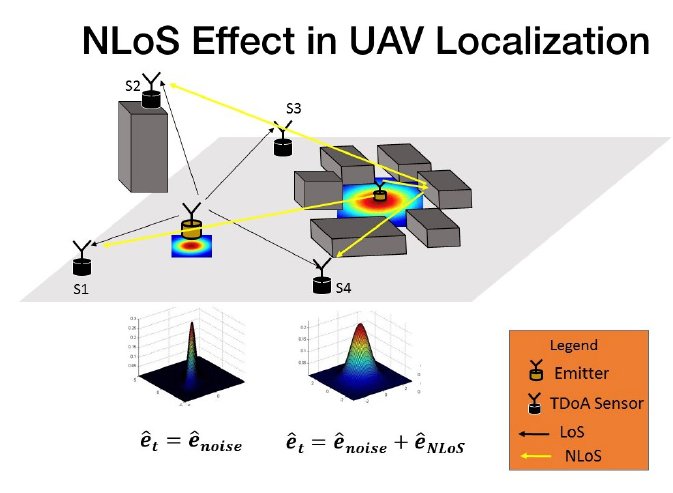
Figure 5. The error produced in TDOA location by